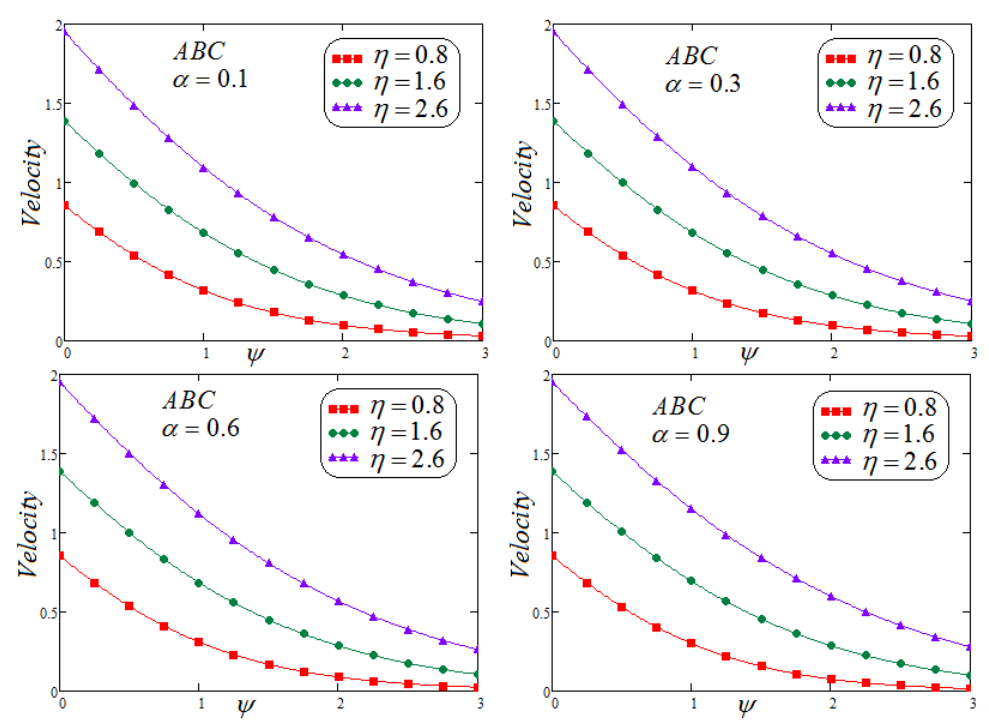
Figure 12. Trace of dimensionless velocity for dissimilar values of η via